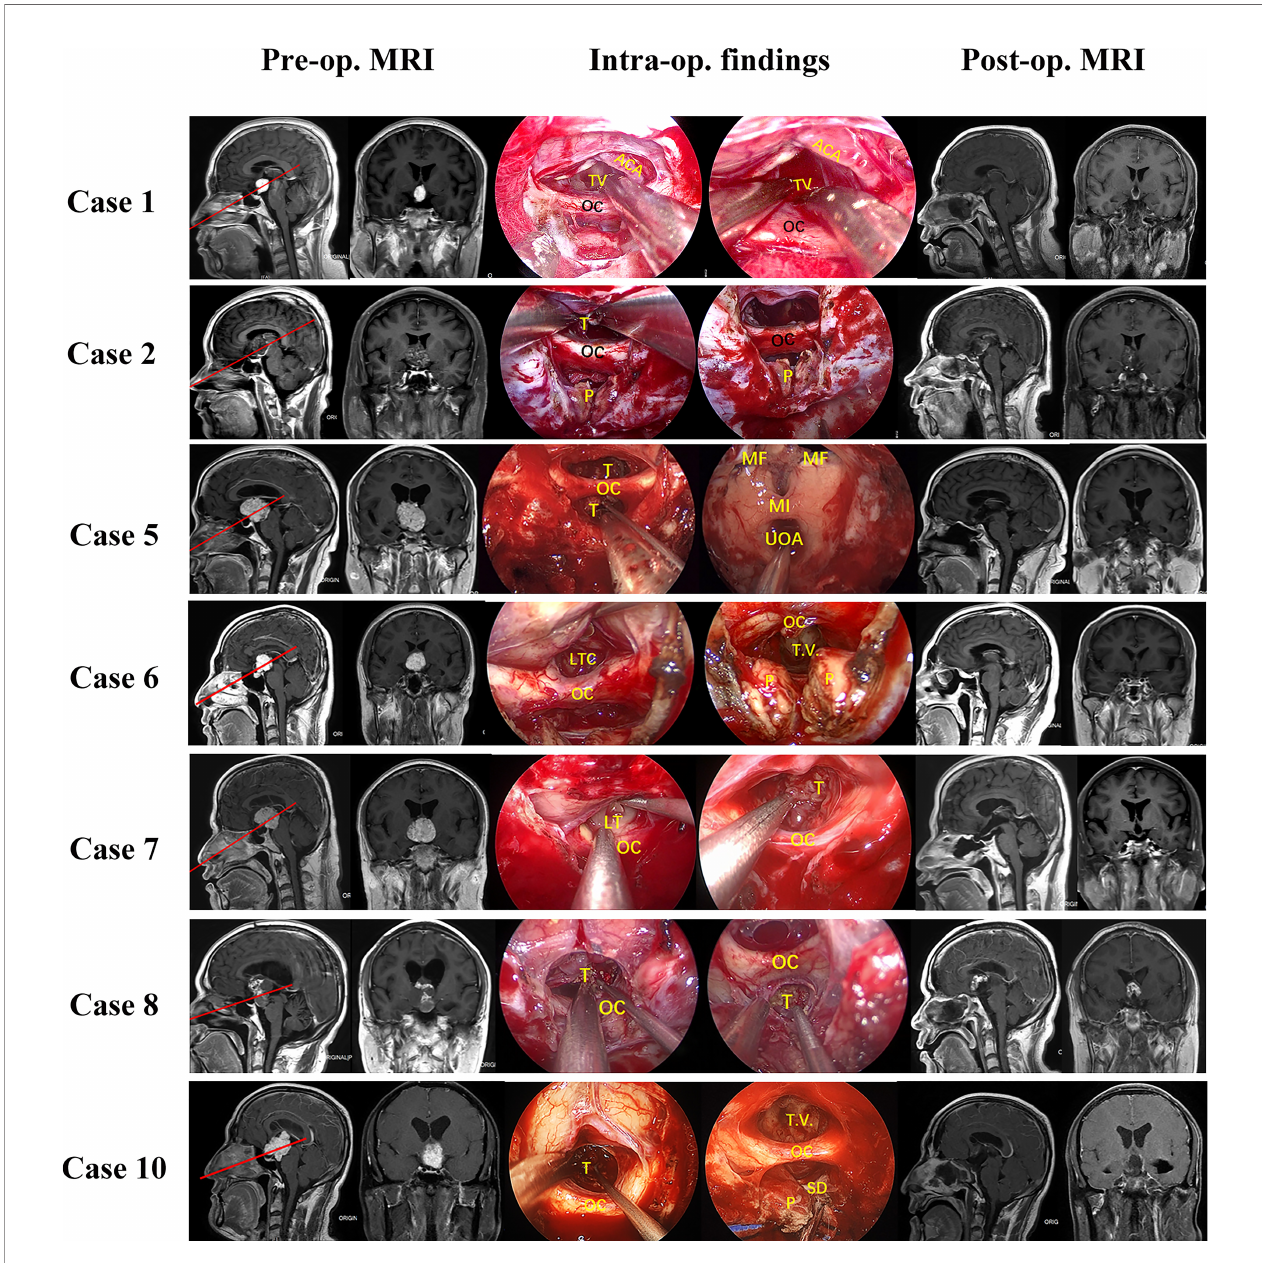
FIGURE 2 | Pre- and post-operative MRI and intraoperative fi ndings of 11 patients treat by trans-lamina terminalis approach combined with trans-pituitary-chiasm corridors. Case 1, a papillary craniopharyngioma located in the 3 rd ventricle with supra-NCL part about 50%. Removing the tumor through EEA with two corridors: suprachiasm trans-lamina terminalis corridor and infrachiasm chiasm-pituitary corridor. The tumor was gross total removed and lateral wall of third ventricle can be seen clearly. Case 2, a cavernous malformation located in the 3 rd ventricle with supra-NCL part about 80%. the tumor was solid with a large draining vein. Both TLTA and TCPC were used to remove the tumor. the tumor was partial removed for protection of the draining vein. Case 5, a papillary craniopharyngioma extended into the 3 rd ventricle with supra-NCL part about 95%. Removing the tumor through EEA with supra-chiasm corridor (trans-lamina terminalis). After the tumor was totally removed, the posterior wall of third ventricle, Monro foramen, and upper outlet of aqueduct can be seen clearly. Case 6, an ACP extended into the 3 rd ventricle with supra-NCL part about 70%. Both TLTA and TCPC were used to remove the tumor totally. Case 7, a papillary craniopharyngioma with supra-NCL part about70% were removed by both TLTA and TCPC. Case 8, an ACP with supra-NCL part about 55% were removed by both TLTA and TCPC. the tumor was adhered internal cerebral vein tightly and encased AComA complex, the superior part of tumor was left for gamma knife. Case 10, a papillary craniopharyngioma with supra-NCL part about 55% were removed totally by TLTA combined with TCPC. Case 11, a papillary craniopharyngioma with supra-NCL part about 90% were removed totally by TLTA. OC, optic chiasm; PS, pituitary stalk; ON, optic nerve; T, tumor; P, pituitary; ICA, internal carotid artery; T.V., 3 rd ventricle; LT, lamina terminalis; HT, hypothalamus; MF, Monro ’ s foramen; TLTA,trans-lamina terminalis approach; TCPC,trans pituitary-chiasm corridor.